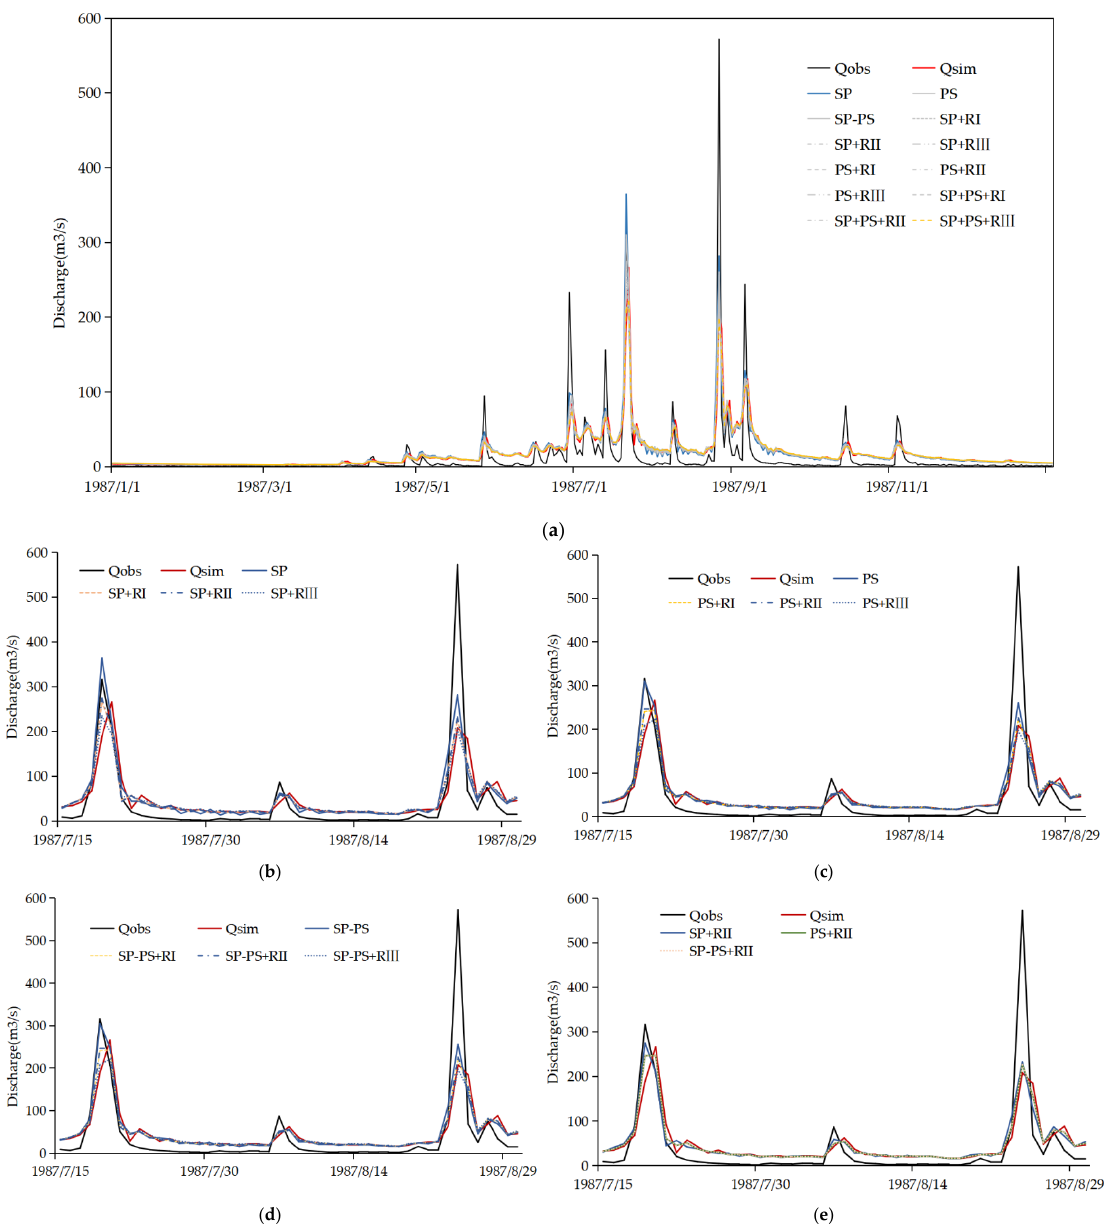
Figure 6. Hydrographs of each regionalization approach of basin YH(ID3). ( a ) Daily hydrograph in 1987; ( b – d ) represent the hydrograph of RA approaches in the flood period; ( e ) represents a comparison of SP/PS/SP-PS+RII in the flood period.